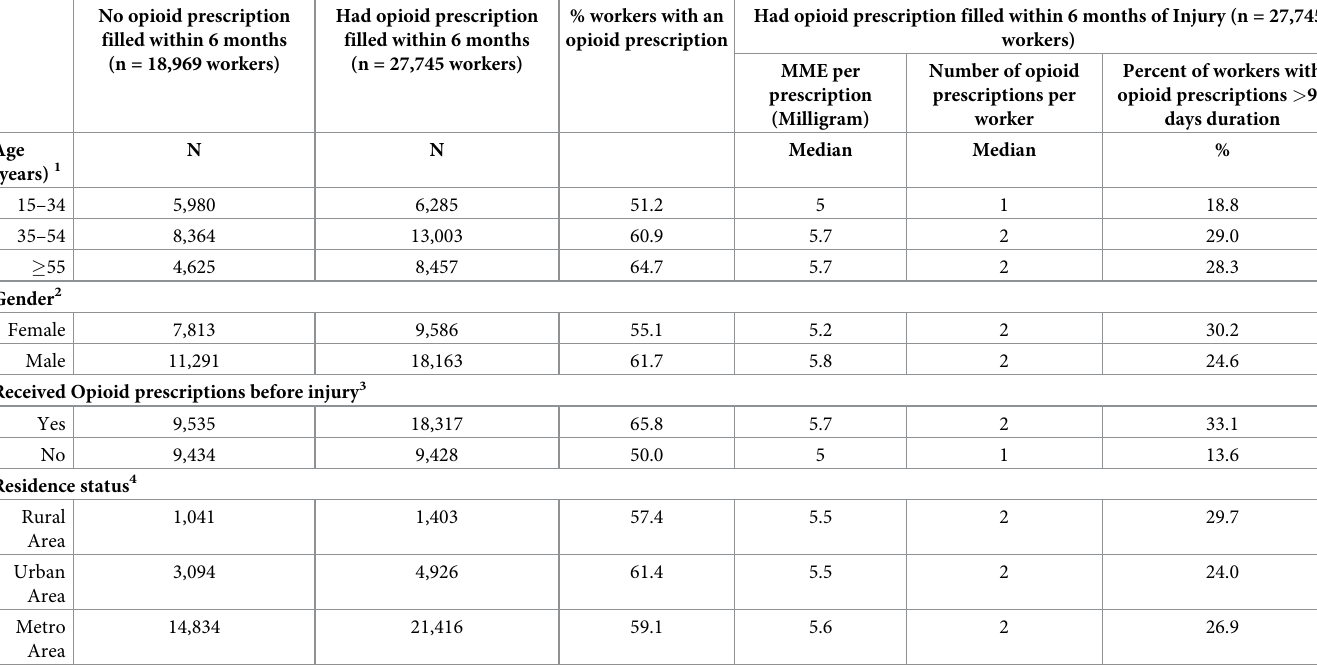
Table 2. Percent of workers with an opioid prescription, median MME per prescription, median number of opioid prescriptions per worker and percent of workers with opioid prescriptions > 90 days duration by age, gender, previously prescribed opioids, and urban/rural residence of workers within 6-months of an injury with a paid wage replacement WC claim, 2016–2018 combined (n = 46,714 workers). No opioid prescription filled within 6